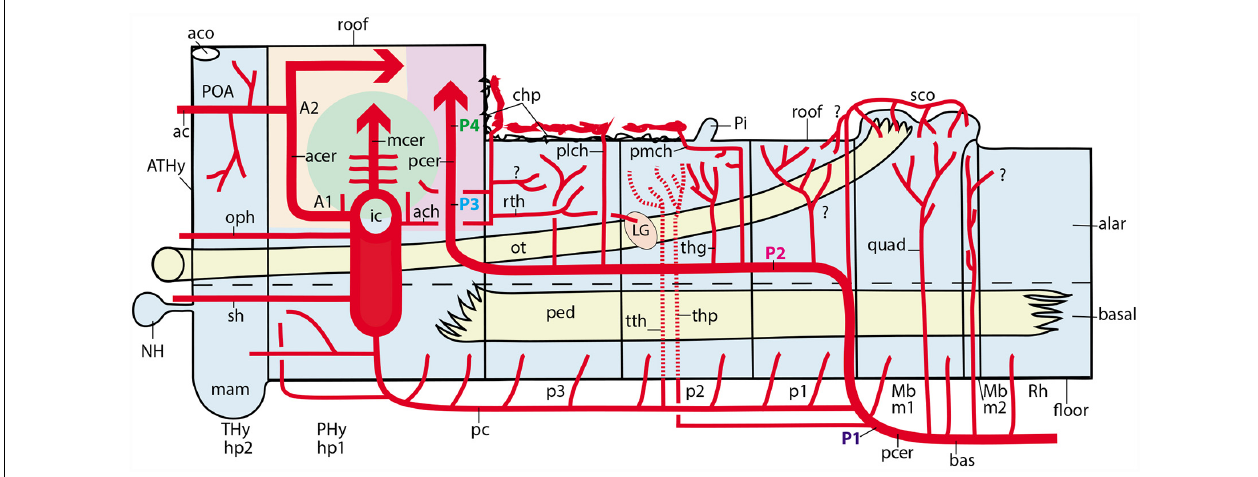
FIGURE 10 | Schematic topologic representation of known or newly postulated forebrain arterial vessels mapped upon the prosomeric model. As regards the topologic forebrain map, which essentially reproduces the semi-realistic version of Figure 1A , its axial dimension has been straightened [elimination of the cephalic flexure, straight floor, straight alar-basal boundary (dash line), nearly straight roof (this has a step as the evaginated telencephalon is reached, for clarity, but even this might be straightened out), and, accordingly, the basal and alar plates also are straight]. Reference structures such as the cerebral peduncle (ped) and the optic tract (ot) are straight or nearly straight. All neuromeres and interneuromeric borders are orthogonally transversal to the axial dimension. In these conditions, it is possible to represent faithfully spatially oriented structures such as the arteries. Dorsal is the direction into the roof, while ventral directs into the brain floor; rostral lies to the left, and caudal to the right. The main subarachnoidal vessels serving this territory derive from the ic, pc, pcer, and bas arteries. One should first examine these fundamental vessels. The ic courses transversally in ventrodorsal direction next to the PHy (crossing the ot); it is thus parallel to the peduncular hypothalamic sector–not shown- tagged as PHy). Its major terminal branches entering transversally into the telencephalon overhead are the acer and mcer vessels, positioned in the map as corresponds after flattening the hemisphere (there is a yellow/green color code for the acer and mcer fields). The posterior telencephalic field is covered by the final, similarly transversal, segment of the pcer (pale violet code). The thick arrows in each case represent simplified pallial arborizations, whereas central branches to the subpallium appear as thin collaterals. The acer also gives out the ac artery which importantly serves the preoptic (POA) and septal regions (the septum lies near the telencephalic roof, paradoxically, and surrounds the anterior commissure, aco, which fate-maps as the rostral end of the roof). The median front of the forebrain is given by the acroterminal preopto-hypothalamic domain (ATHy). Note the optic chiasma (unlabeled) and the neurohypophysis (NH) lie at alar and basal levels of this acroterminal area, respectively. The sh and oph branches of the ic are thus longitudinal arteries. The pc vessel arises from the ic and then topologically descends first along the PHy and then bends caudalwards into a longitudinal para-tegmental course until it meets the pcer near its origin from the bas. Our topologic straightening of the normally bent length dimension has caused the pc to appear as long as it topologically is, though this is not seen in the unstraightened brain, where we mostly see its short transversal hypothalamic course. The pcer continues bilaterally the median bas artery but changes its relative position by contouring dorsalward the peduncle (in front of the midbrain) into a ventral alar level, which it then uses to extend rostralward (longitudinally) until it enters into the telencephalon. This is the basic layout. The midbrain thus appears as a transitional caudal forebrain domain where the vascular patterns gradually change from typical hindbrain features to typical diencephalic characteristics. This again apparently changes when we arrive at the secondary prosencephalon, where our analysis was handicapped by scarce and confusing data (this is the less detailed part of our vascular map, but it can be developed in the future). One fundamental pattern that is pretty clear is that the brain basal plate is irrigated separately from the larger alar plate. A multiplicity of basal (mediobasal or laterobasal) arteries enter the basal tegmentum at all neuromeric levels, as predicted originally by His (1895, 1904) and as expected by the prosomeric model (not so the columnar model, which predicts that basal arteries should extend through the acroterminal dimension into the subpallial telencephalon; there is no sign of that). These basal plate vessels arise sequentially from the as, ve, bas, pcer (P1) and pc arteries. With exception of the thalamic perforant arteries (tth, thp; seen by transparency), which first behave as basal vessels, but then extend intraneurally into the alar domain, a separate set of arteries address the hindbrain, midbrain and diencephalic alar plate. In the hindbrain a pattern of ventroalar and dorsoalar arteries arising from the bas or ve vessels (commonly known as short and long circumferential branches) is clearly repeated, even when some segmental vessels add a jump into the overhanging cerebellum, a morphogenetic deformation (pic, aic, sc). Most dorsoalar hindbrain arteries may give out chorioidal branches. The midbrain also has dedicated alar arteries, such as the quad at the m1 mesomere, possibly duplicated at the m2 companion segment; they arise from the bas or pcer P1. The map next shows that the diencephalic alar plate is covered by successive neuromeric alar branches of the pcer, some of which (in p2 and p3) are chorioidal branches. The pattern thus has changed by moving the bas-like pcer bilaterally to a longitudinal course which is displaced to an alar topology (compare Figure 8C ). Apart the midbrain basal branches of the pcer P1, diencephalic basal branches largely originate from the pc artery. The map also places the route and ending sites of the pmch and plch arteries, in contrast with the ach artery, which oddly also produces a recurrent thalamic branch (rth) which targets the lateral geniculate body by extending longitudinally, but backward, into at least the prethalamus and the